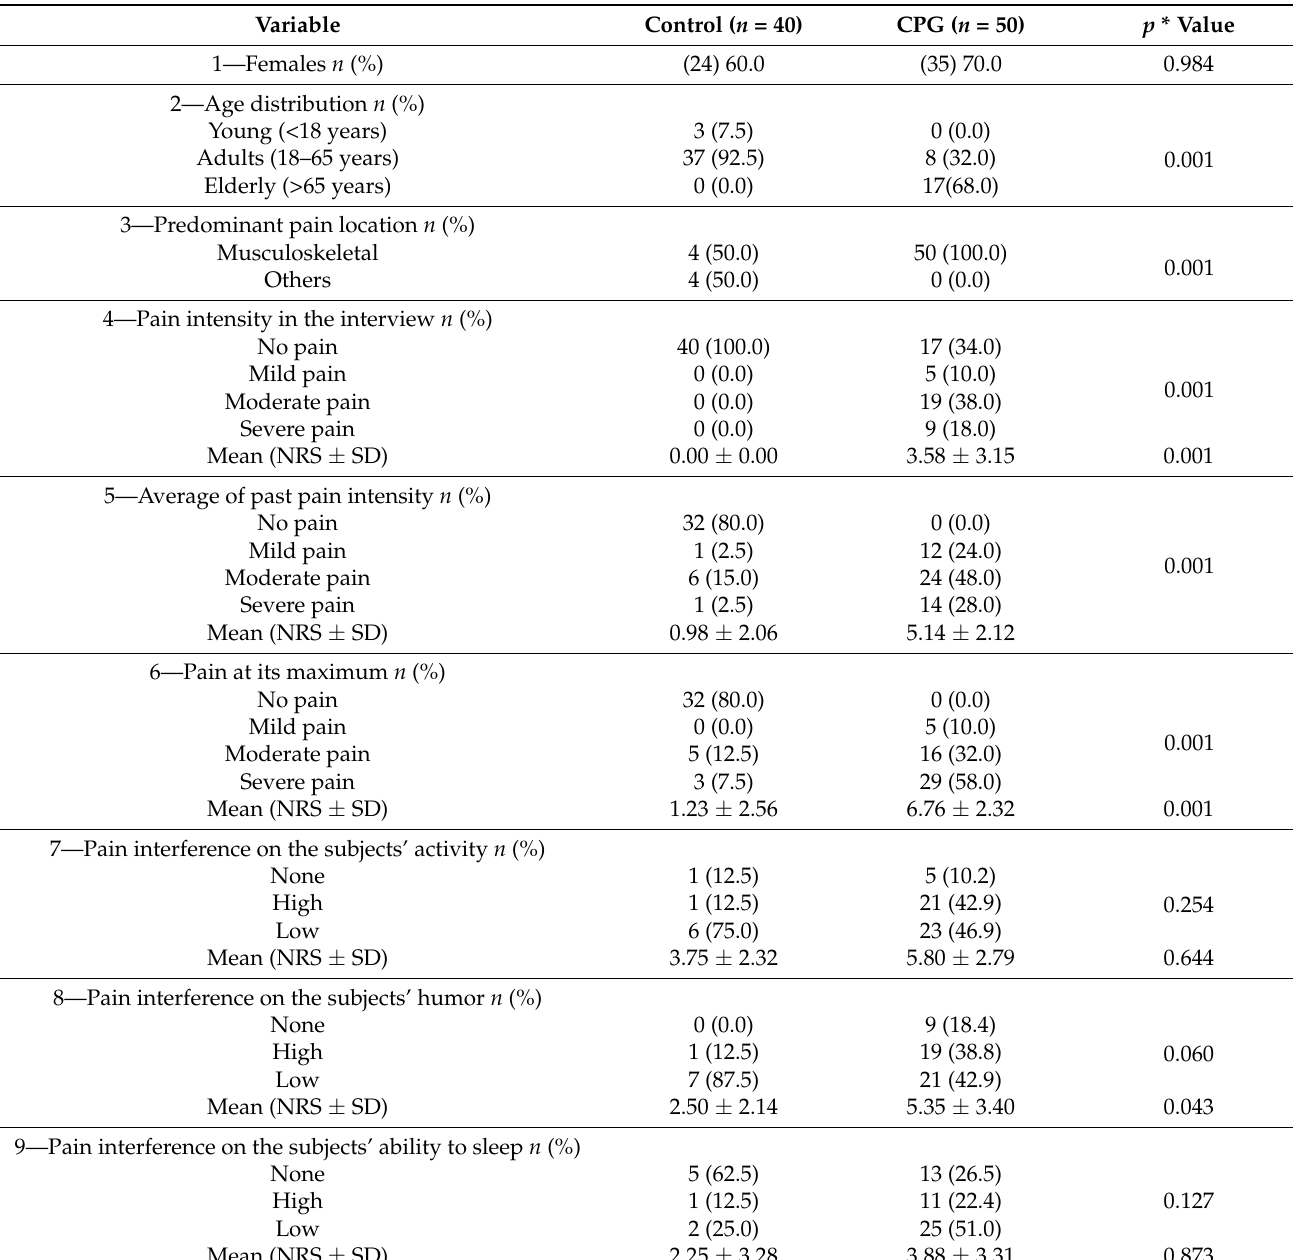
Table 1. Comparative analysis between the control group and the chronic pain group (CPG) ( n =